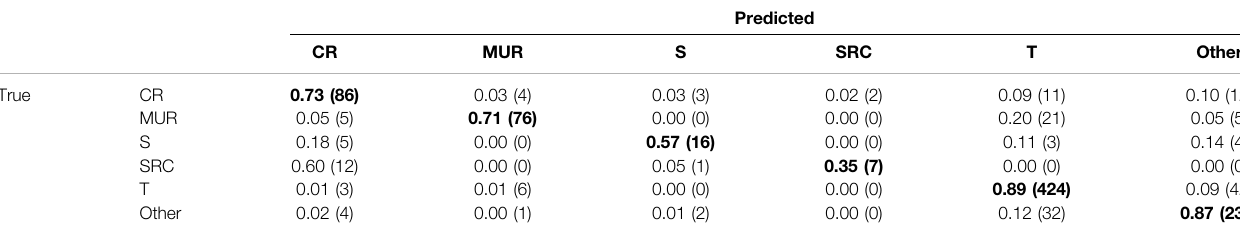
TABLE 2 | Confusion matrix computed on the test data set. Rows show the true class, and the columns the CNN-identi fi ed class. Correct predictions follow the diagonal, highlighted in bold. As an example, 73% of CR buildings are correctly identi fi ed, but 3% are classi fi ed as MUR, 3% are classi fi ed as S, 2% SRC, 9% as T and 10% as other. In parentheses are the actual number of